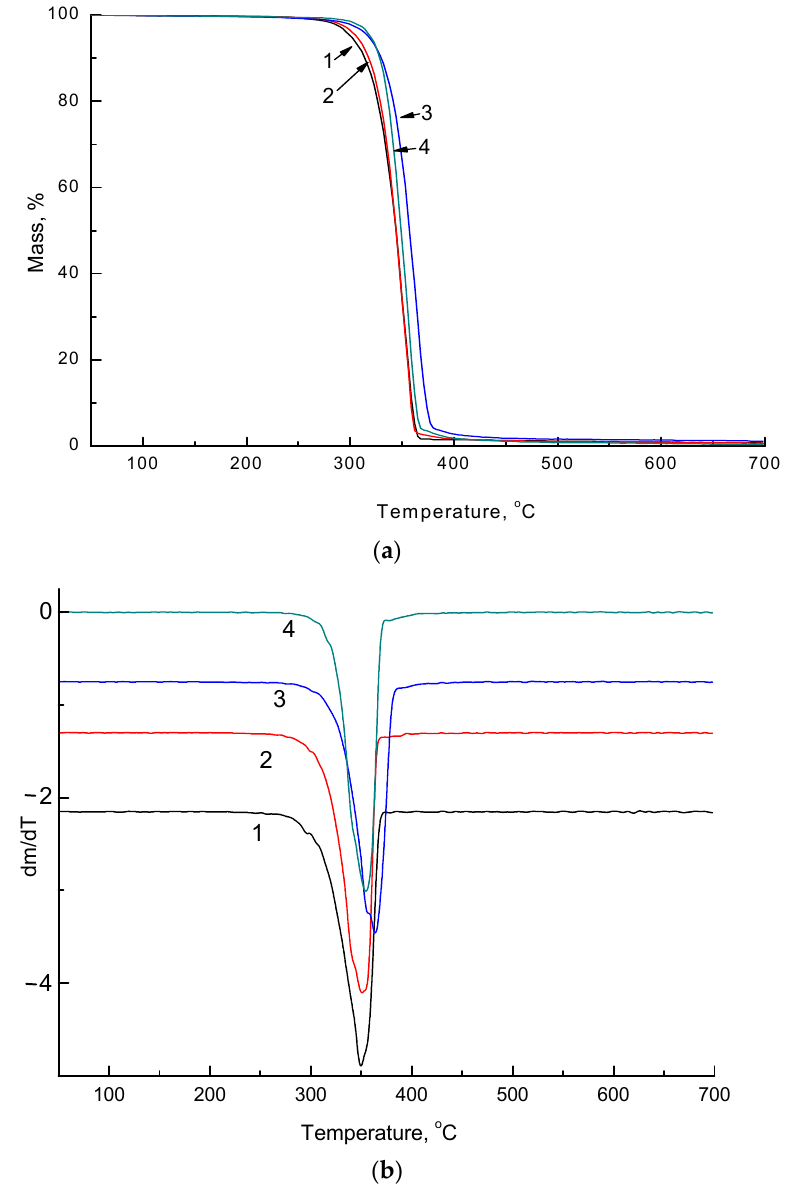
Figure 8. TGA ( a ) and DTG ( b ) thermograms of PLA/NR samples with different NR content, wt.%: